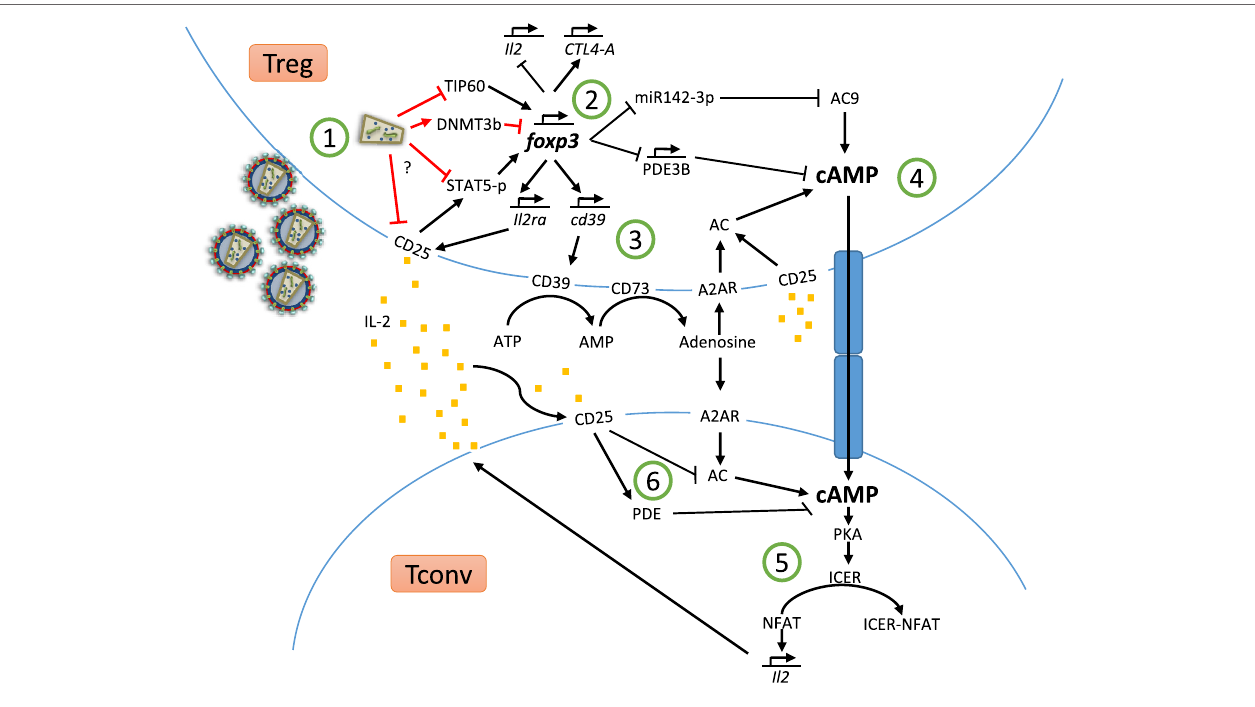
FiGURe 1 | Treg suppressor mechanisms and Hiv-dependent Treg